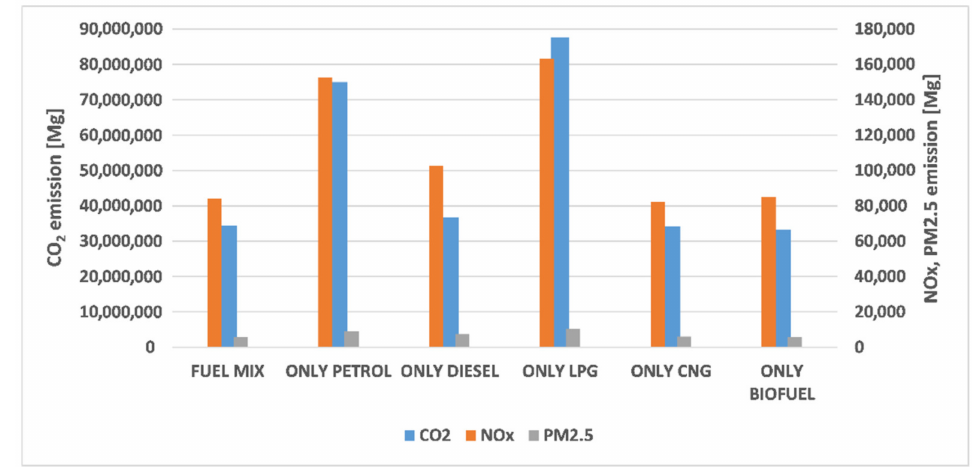
Figure 3. Comparison of CO 2 , NOx, and PM2.5 emissions depending on fuel